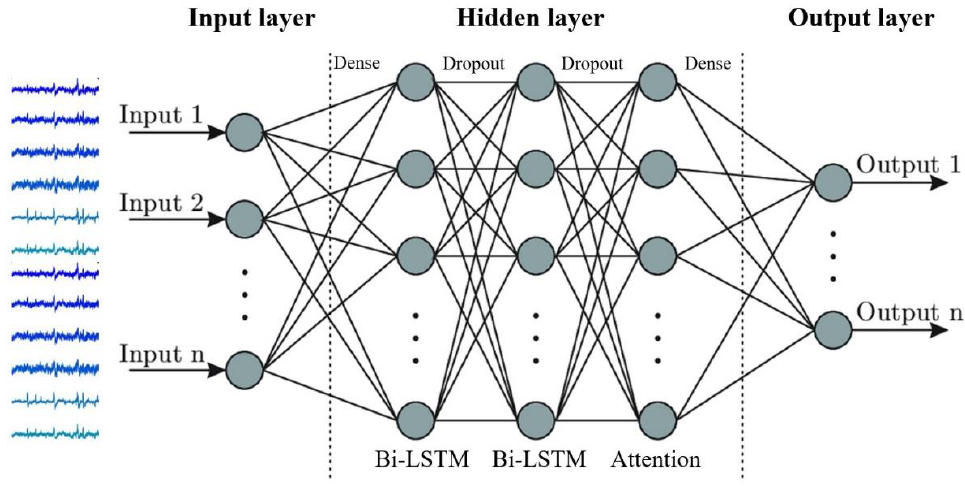
Figure 2. LSTM network structure with an attention mechanism.